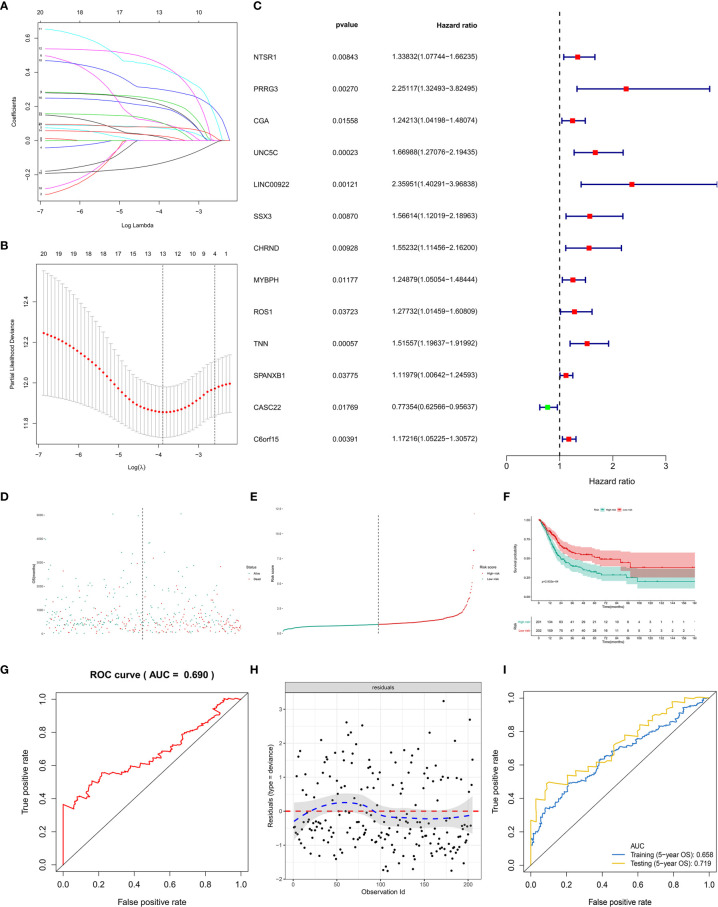
The model diagnosis of multivariate Cox model including prognostic stemness-related genes. (A) The final multivariate model of the 20 prognostic stemness-related genes. (B–E) The LASSO regression analysis of the model. (F) The Kaplan-Meier analysis of the risk score. The ROC curve (G) and residual plot (H) of the multivariate model. (I) And the five-fold cross-validation of the multivariate Cox model was performed, also showing similar discriminations to the original model (AUC of training dataset (5−year OS) = 0.658; AUC of testing dataset (5−year OS) = 0.719).